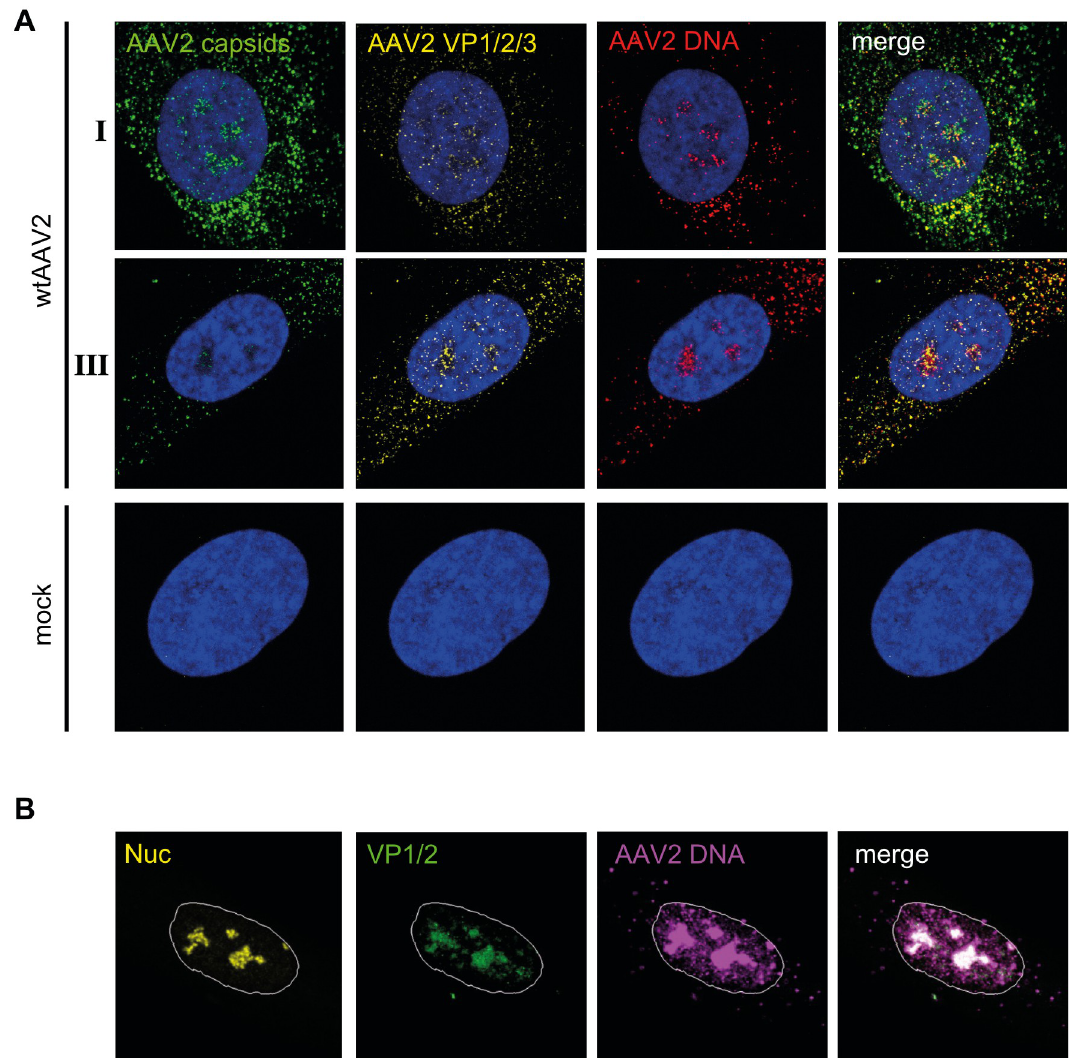
Fig 6. Co-detection of AAV2 DNA with AAV2 capsids and AAV2 capsid proteins. NHF cells were infected with wtAAV2 (MOI 20‘000). At 24 hpi, the cells were fixed and processed for multicolor IF analysis combined with FISH and CLSM. (A) Intact capsids (green) or capsid proteins (yellow) were detected using either an antibody against intact AAV2 capsids (conformational capsid epitope) or an antibody (linear epitope) against VP1, VP2 and VP3. AAV2 DNA (red) was detected with an Alexa Fluor (AF) 647 labeled, amine-modified DNA probe that binds to the AAV2 genome. Nuclei were counterstained with DAPI (blue). The wtAAV2 infected cells shown were assigned as pattern I and III according to the intensity of the capsid staining and following a similar classification as defined in Fig 4. (B) AAV2 capsid proteins (green) were detected using an antibody (linear epitope) against VP1 and VP2. AAV2 DNA (magenta) was detected by linking the amine-modified DNA to AF647. Nucleoli (Nuc) were visualized using an antibody against fibrillarin (yellow). Nuclei were counterstained with DAPI and illustrated as white